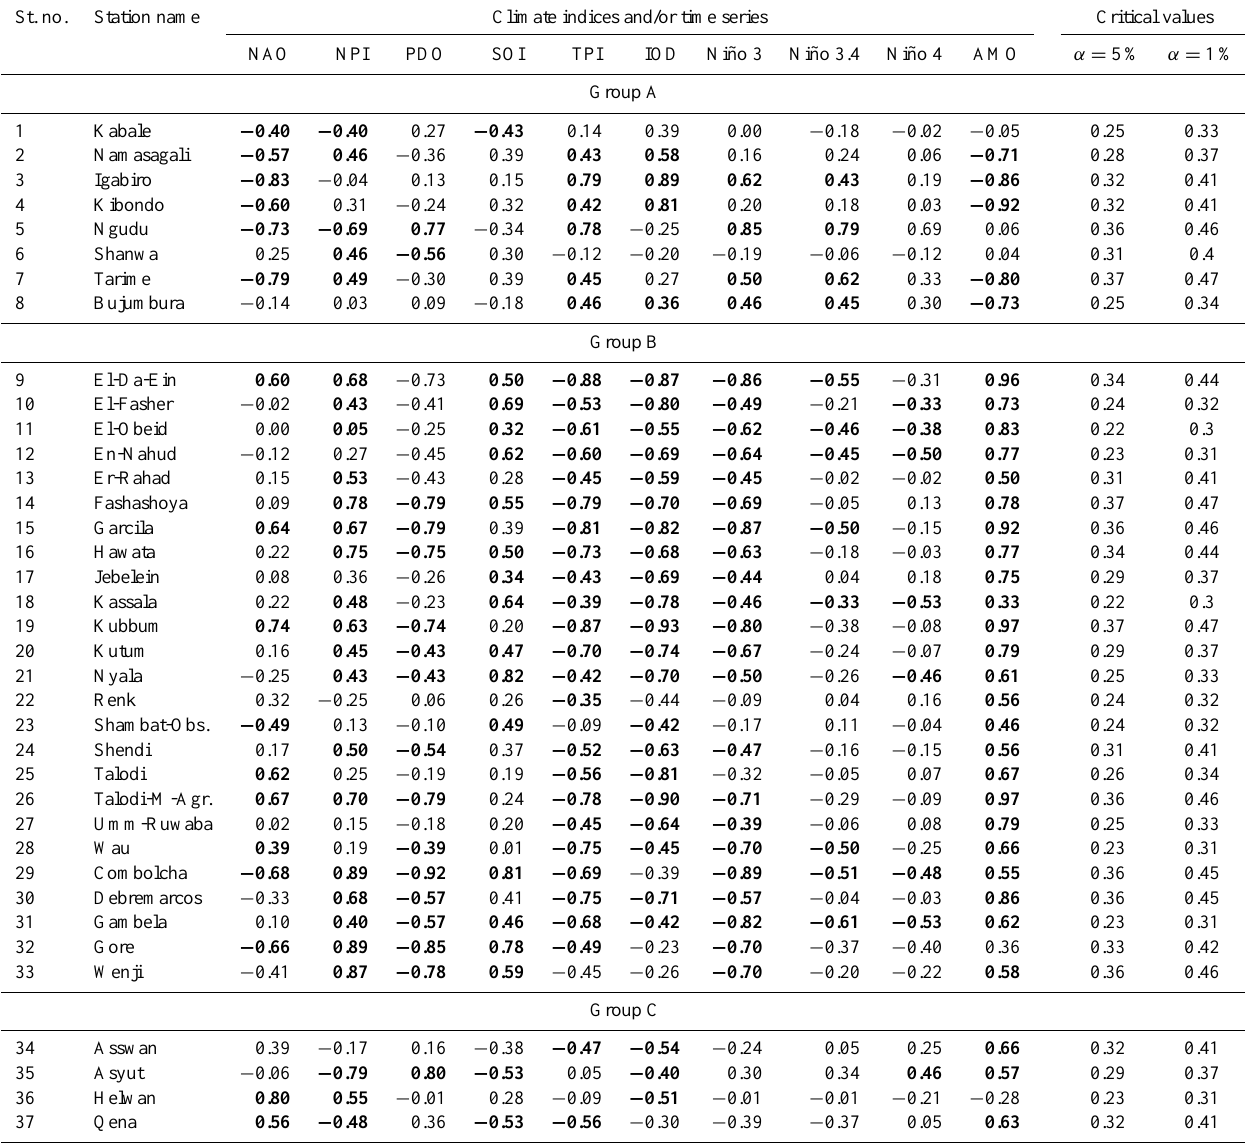
Table 5. Correlation between QPM results for annual rainfall and climate indices considering full series with lengths of data records shown in Table 1. St.